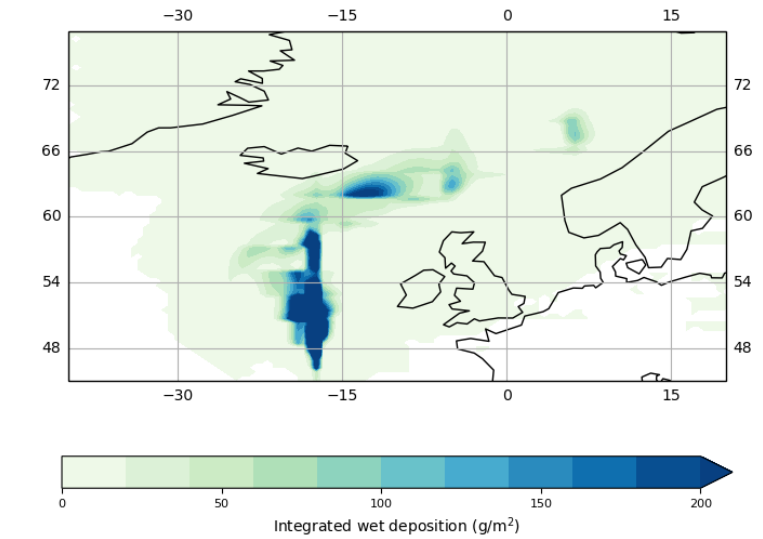
Figure 7. Ensemble mean wet deposition integrated over the duration of the Grímsvötn eruption (21–25 May